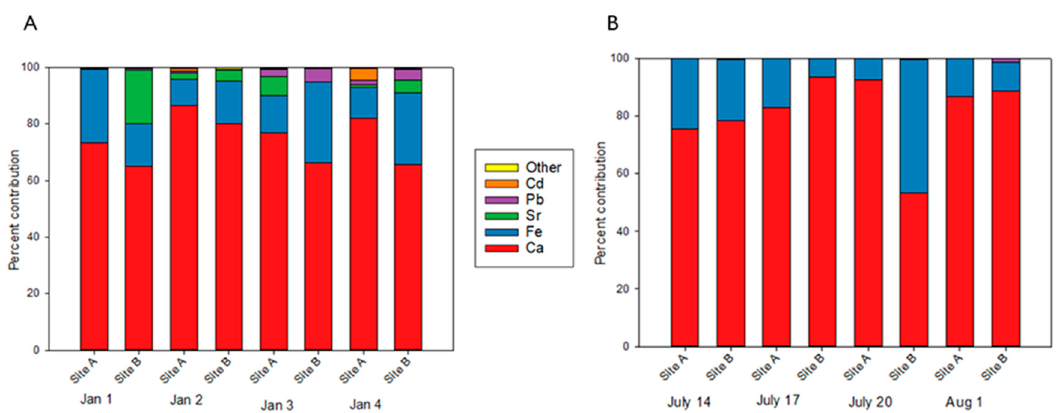
Figure 3. Elemental compositional profiles. Percent contributions of elements for each day and site are represented for winter ( A ) and summer ( B ) in January (Jan) and July. All values are reported out of 100% of the total elemental concentration for individual sampling days / sites. The legend represents elements with their corresponding colors. “Other” represents the combined contribution of Cs, Tl, U, and Ag.